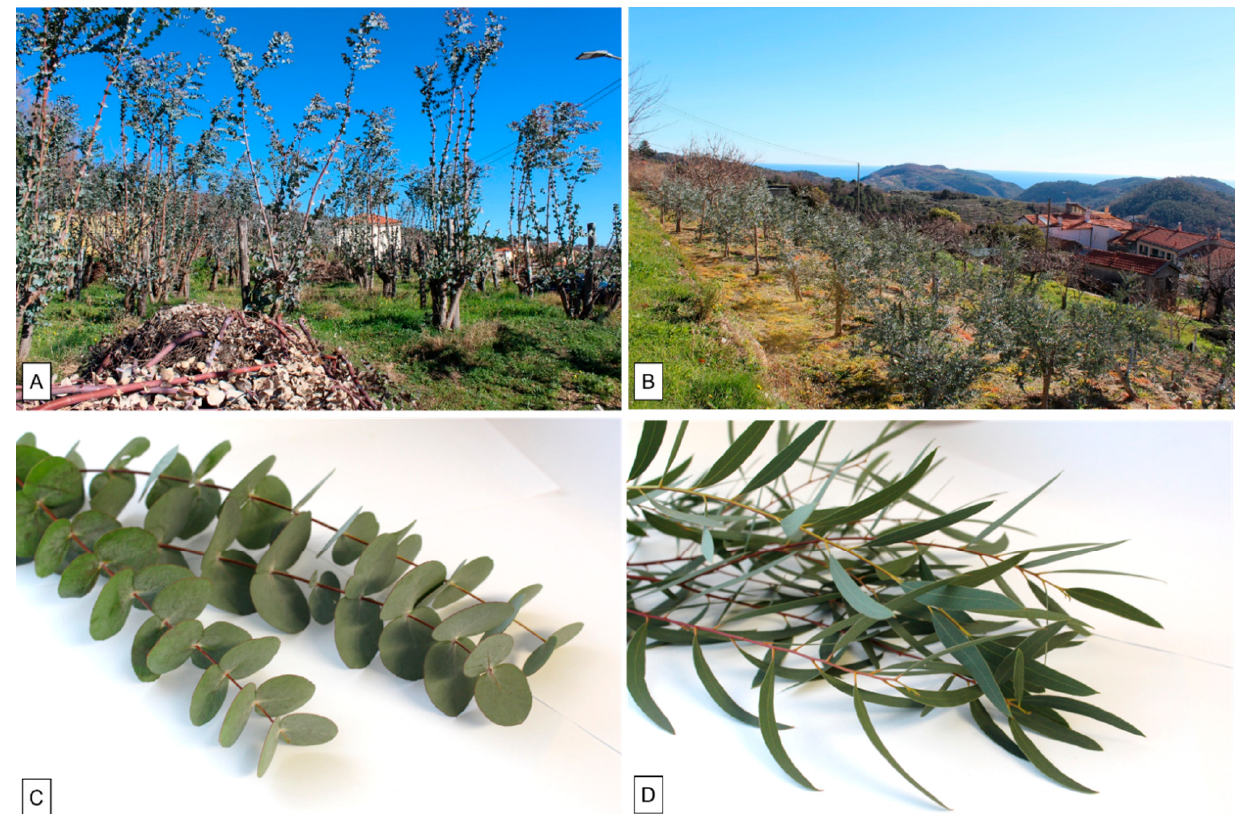
Figure 6. Plantations and collected branches of E. cinerea ( A , C ) and of E. nicholii ( B , D ).